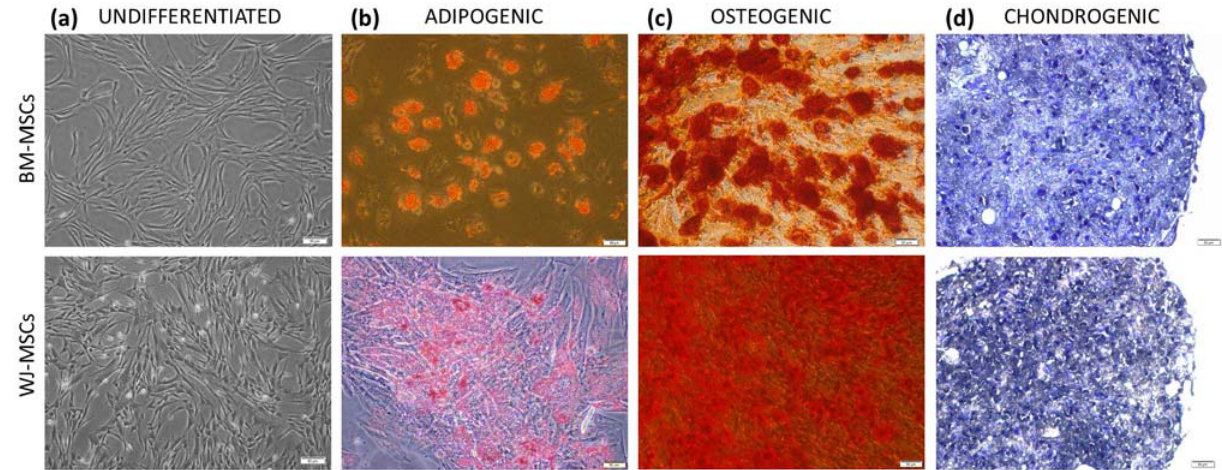
Figure 1. The morphology and differentiation potential of BM-MSCs (upper row) and WJ-MSCs (lower row). Light microscopy. ( a ) morphology of undifferentiated MSCs; ( b ) MSCs after adipogenic differentiation, lipid droplets stained with Oil Red O; ( c ) MSCs after osteogenic differentiation, calcium deposits stained with Alizarin Red; ( d ) MSCs after chondrogenic differentiation, proteoglycans stained with Toluidine blue; scale bars—50 µ m.